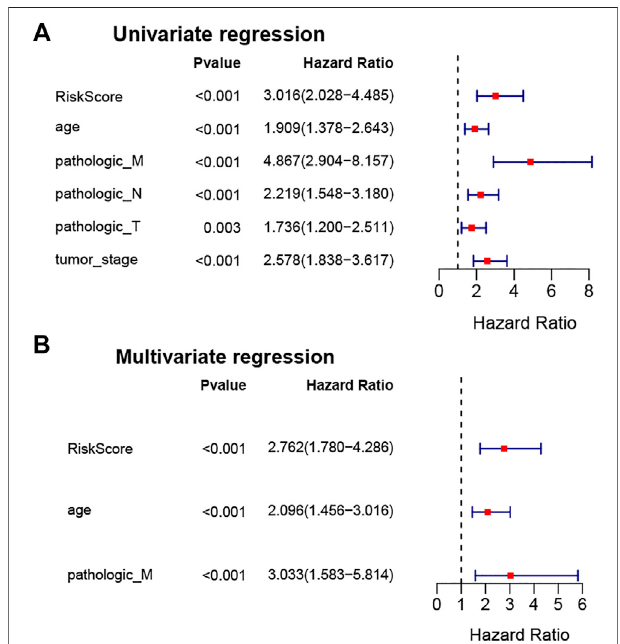
FIGURE 4 | Stemness-index-related lncRNA signature was an independent prognostic factor in BC. Univariate Cox regression analysis (A) and multivariate Cox regression analysis (B) to identify independent prognostic factors from stemness-index-related lncRNAs and other clinicopathological characteristics in TCGA